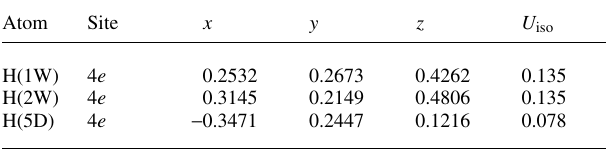
Table 2. Atomic coordinates and displacement parameters (in Å 2 )